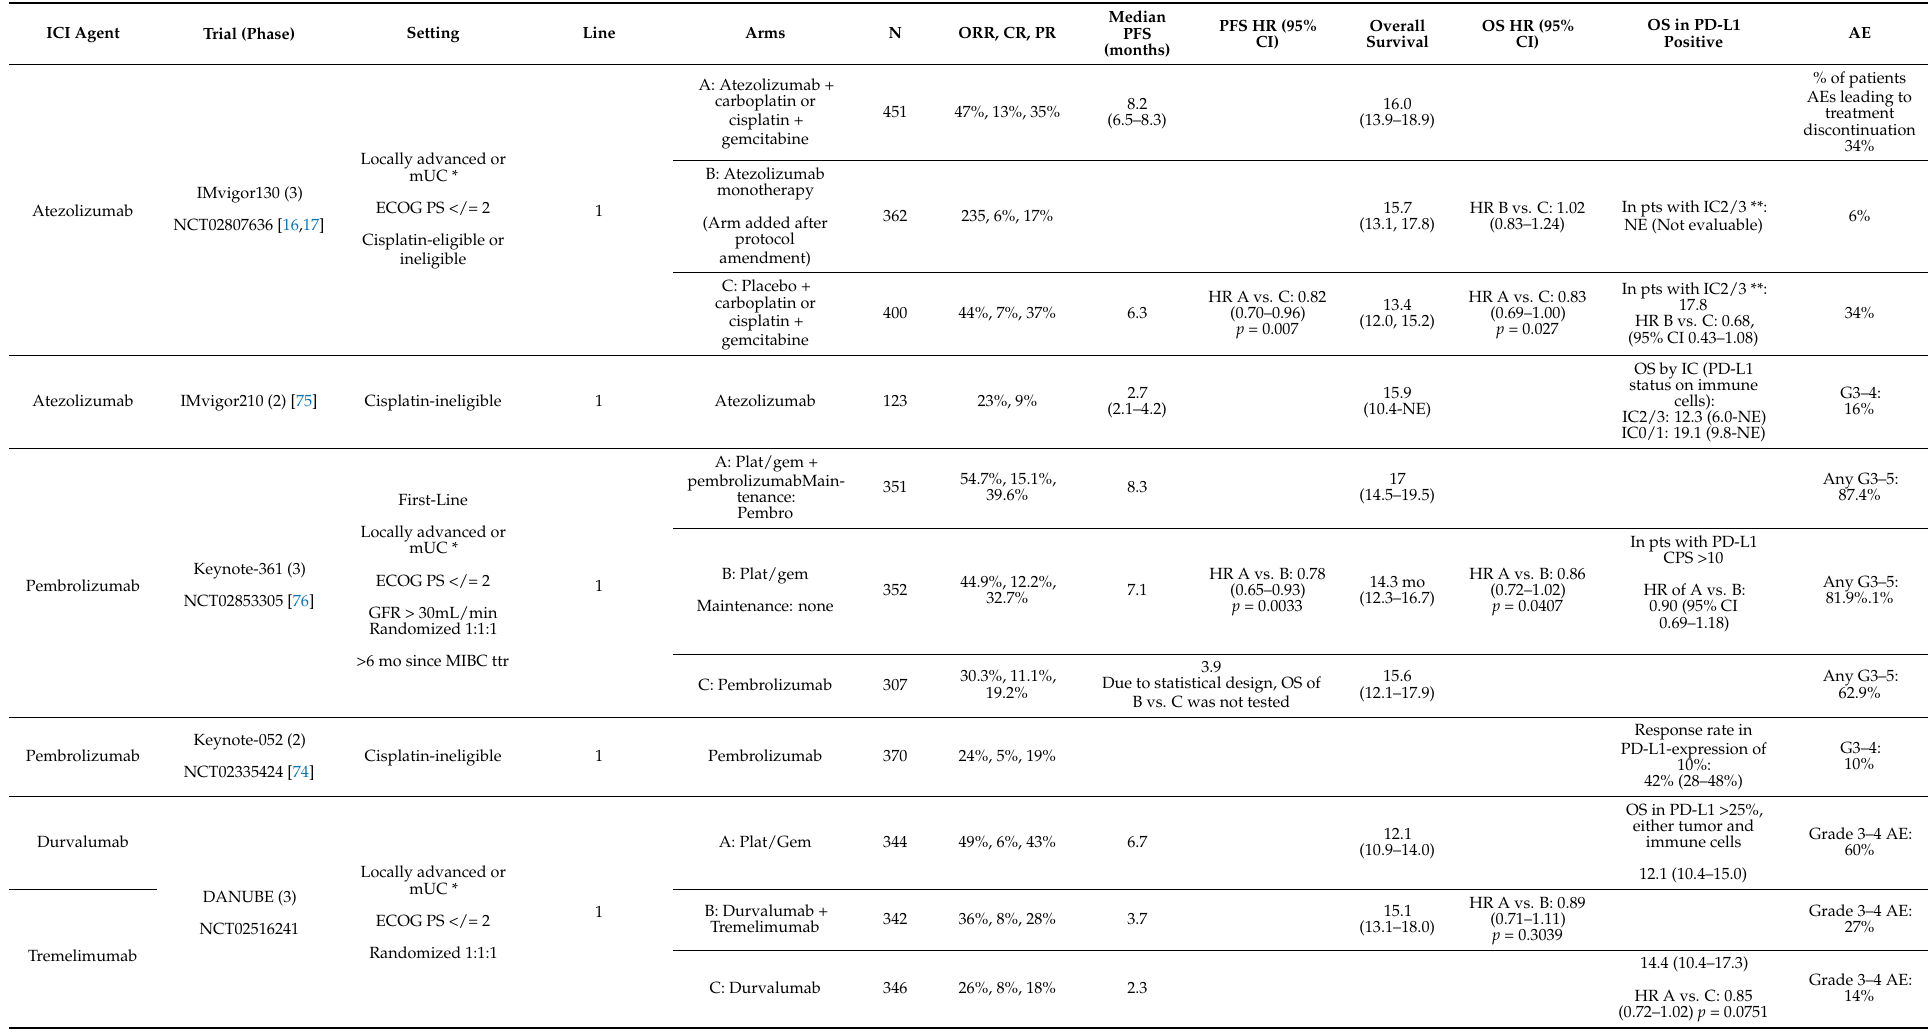
Table 3. ICI clinical trials in urothelial